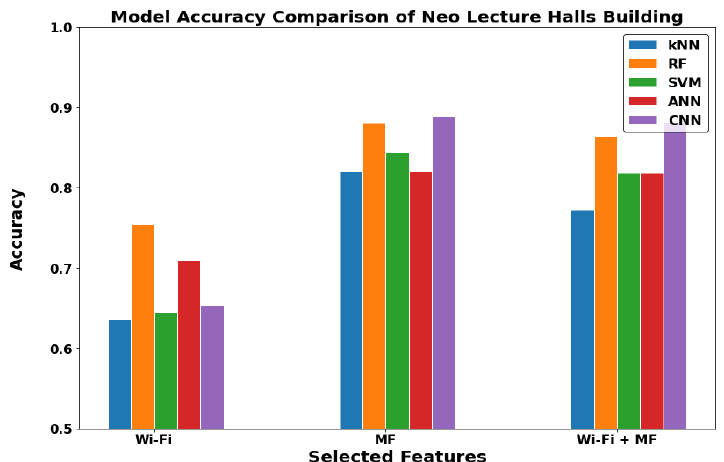
Figure 16. The models comparison in Mechanical department building (Outdoor).